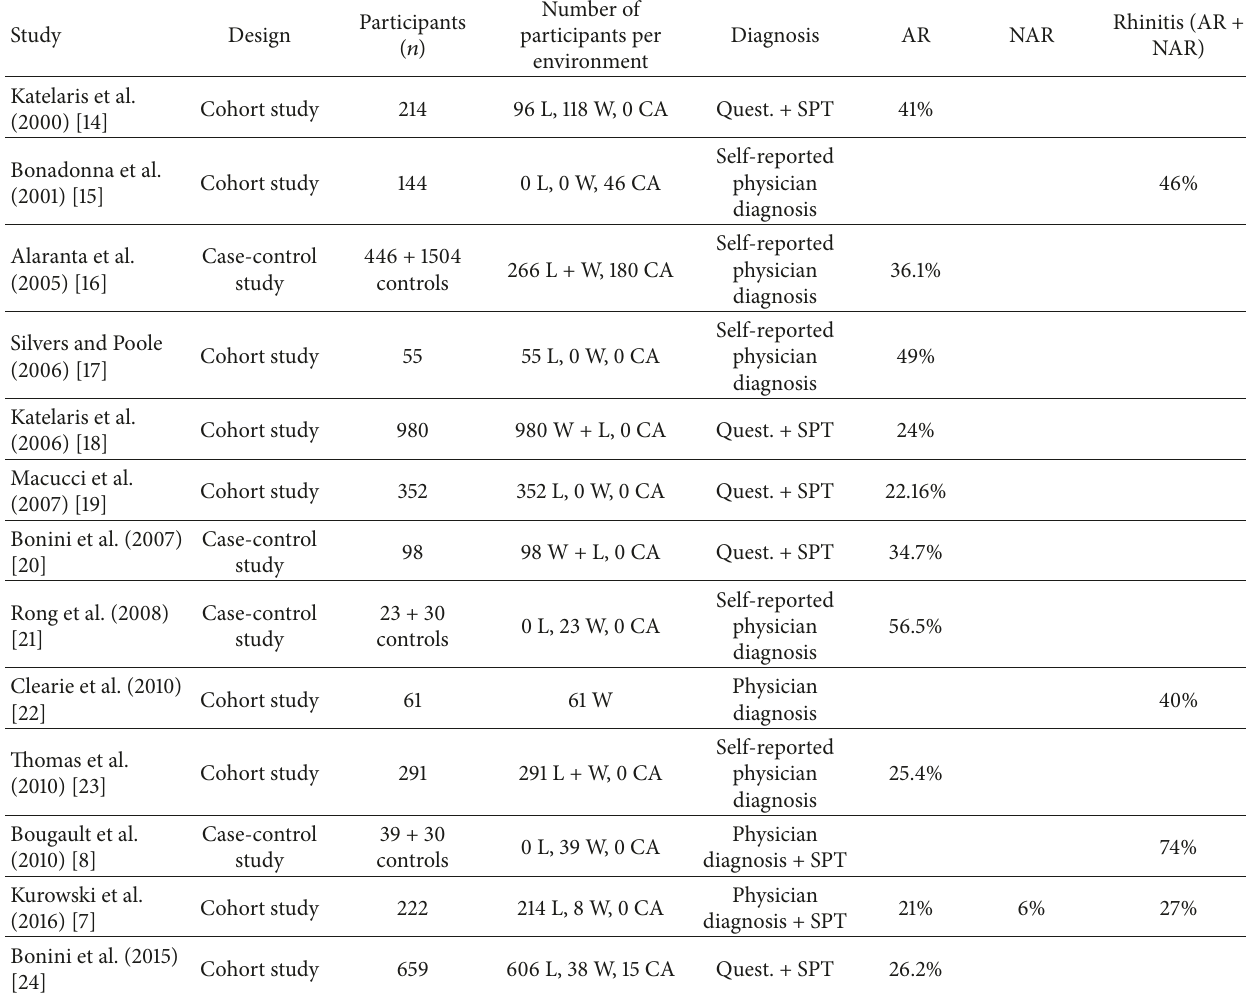
Table 1: Prevalence of Rhinitis in